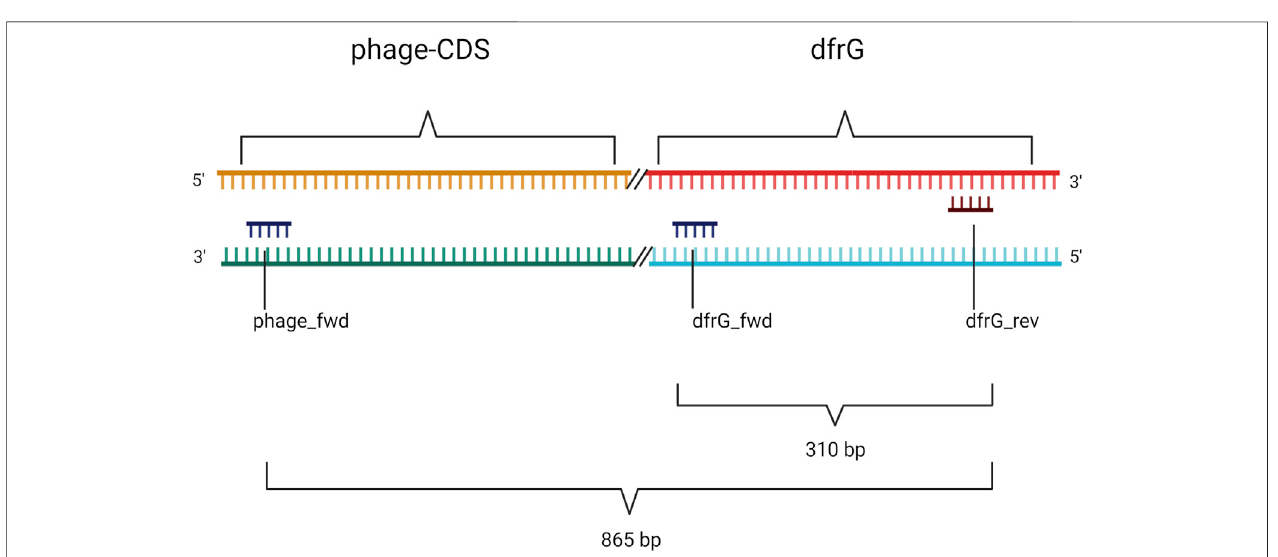
FIGURE 1 | Non-scale arrangement of designated primers for PCR to detect local proximity between the phage-CDS and the dfrG gene. Created with